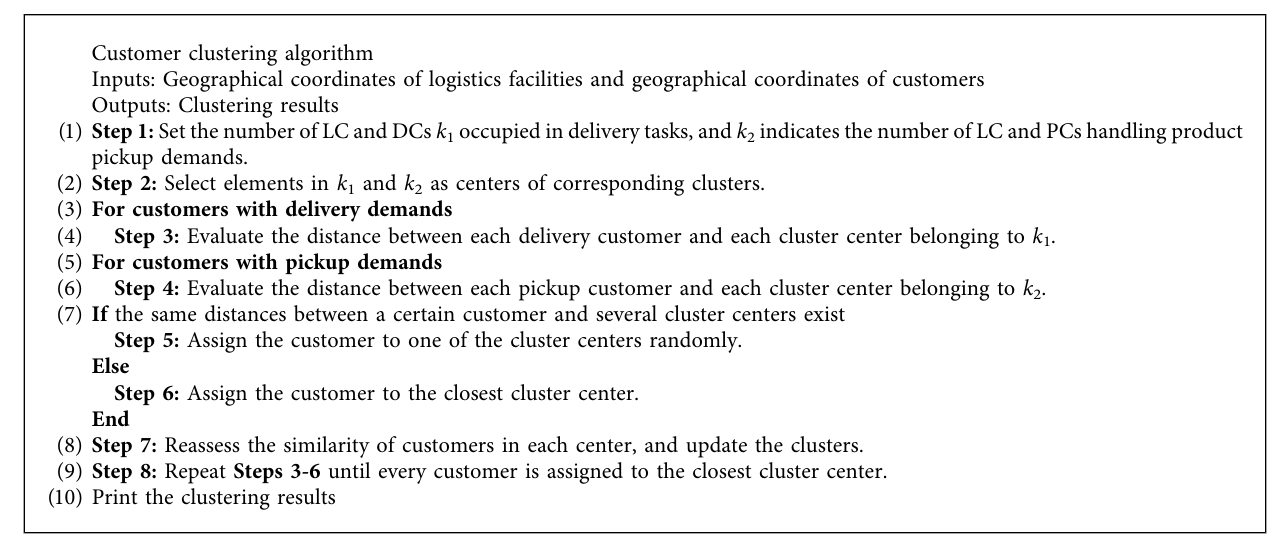
A LGORITHM 1: Procedure of the designed customer clustering